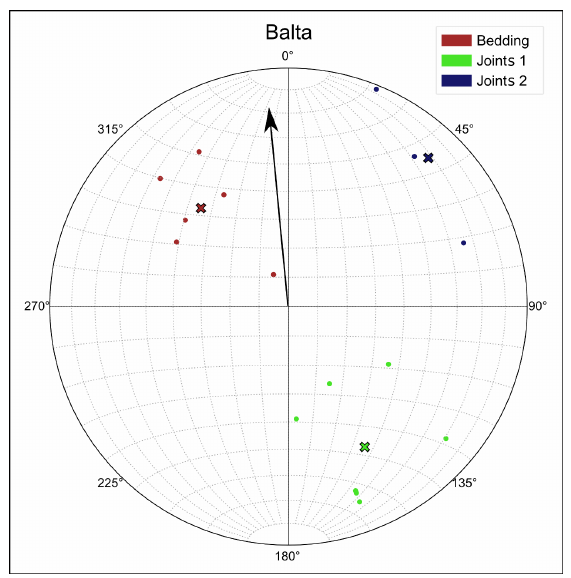
Figure A3. Stereonet of the structural data of the Balta rockslide. Dots are the poles of the great circles and crosses are mean the poles and the black arrow shows the direction of the slide.